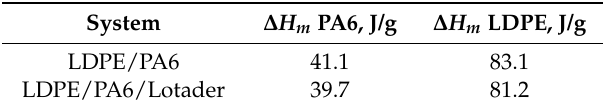
Table 1. Melting enthalpies (obtained from differential scanning calorimetry (DSC) analysis) of the PA6 and LDPE